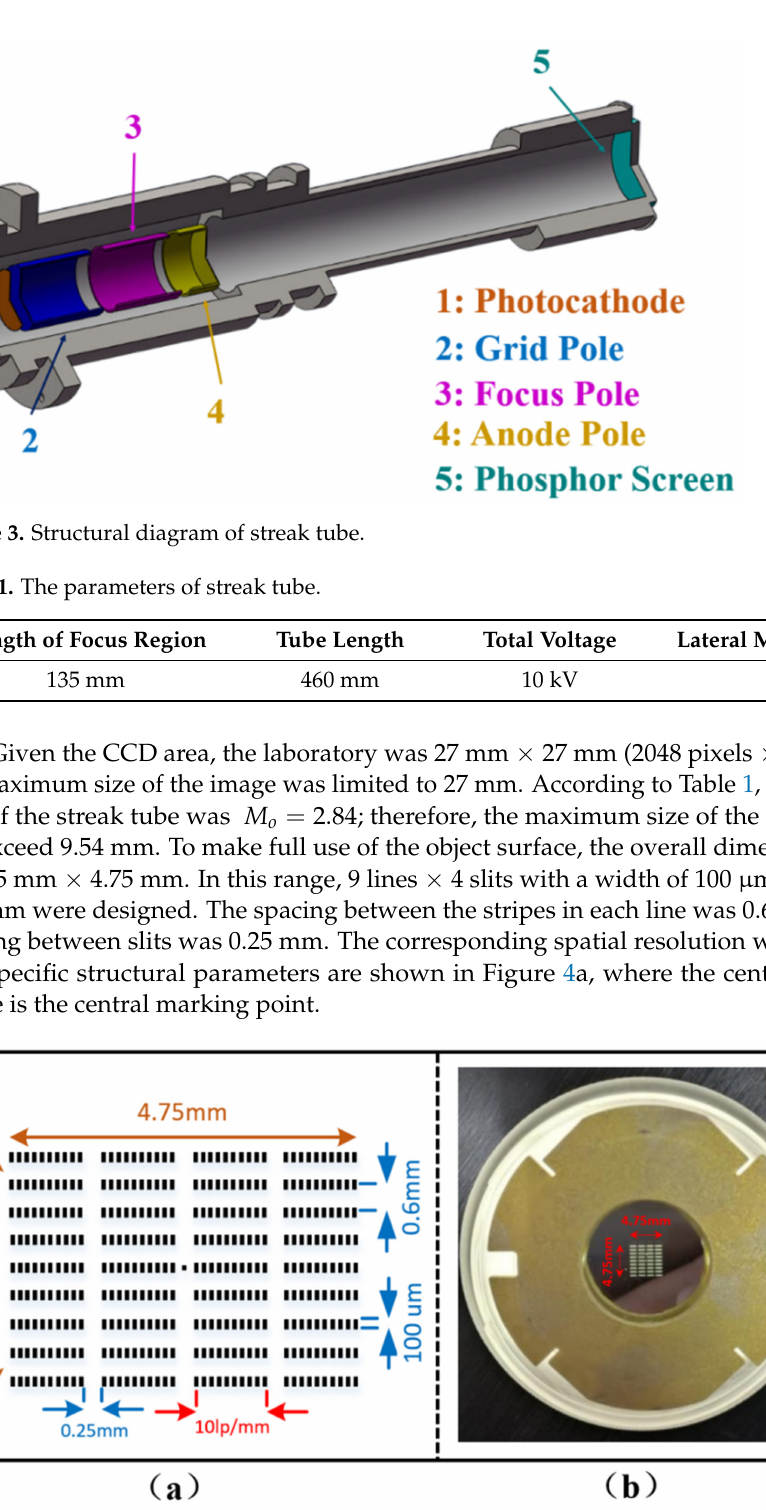
Figure 4. Structural diagram and physical drawing of photocathode: ( a ) schematic diagram of reticle structure; ( b ) physical drawing of